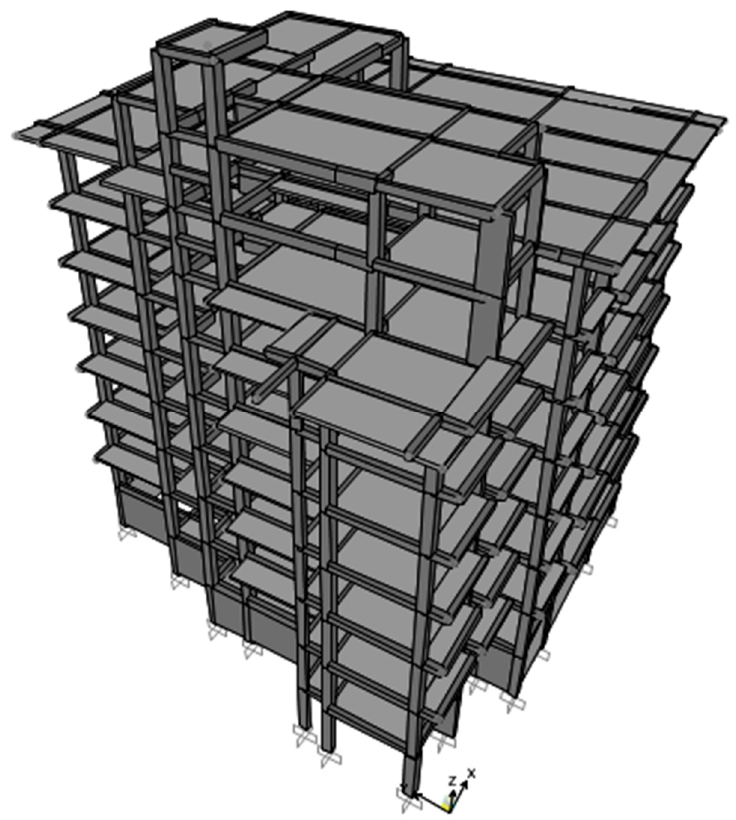
Figure 1. Finite element model of the case study building.